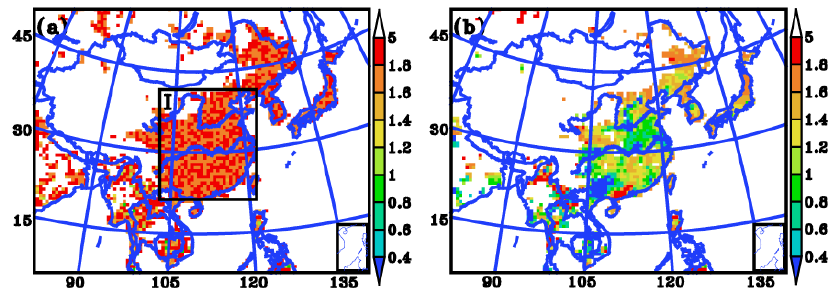
Figure 9. (a) Ratios of monthly mean F ∗ t to monthly mean F p t ; and (b) ratios of monthly mean F a t to monthly mean F p t in February 2010. The white part indicates the ratios where the absolute values of monthly mean F p t are larger than 0.1, not analysed in this study. The black square labelled I indicates the domain where surface CO 2 fluxes were used for the results presented in Figs. 12 and 13.